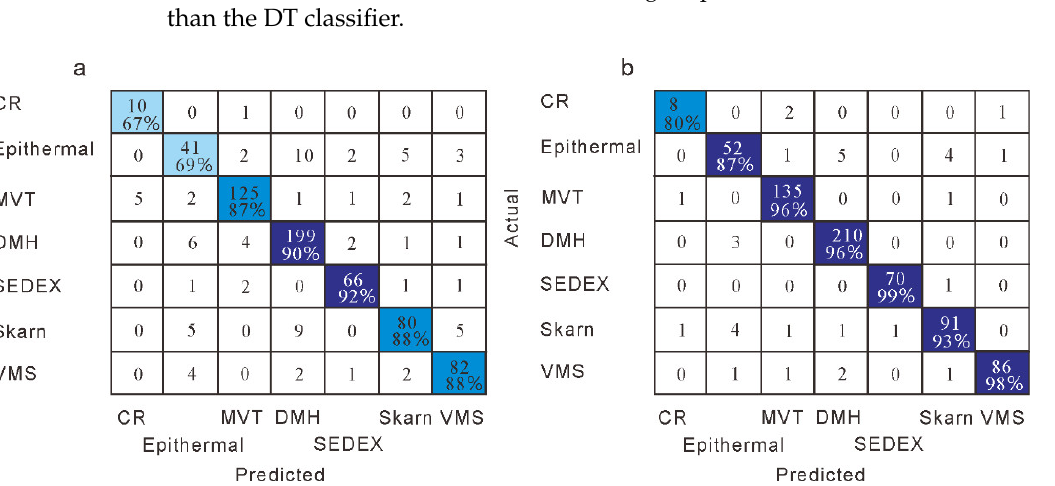
Table 2. Precision, recall, and F1 score of classifiers.